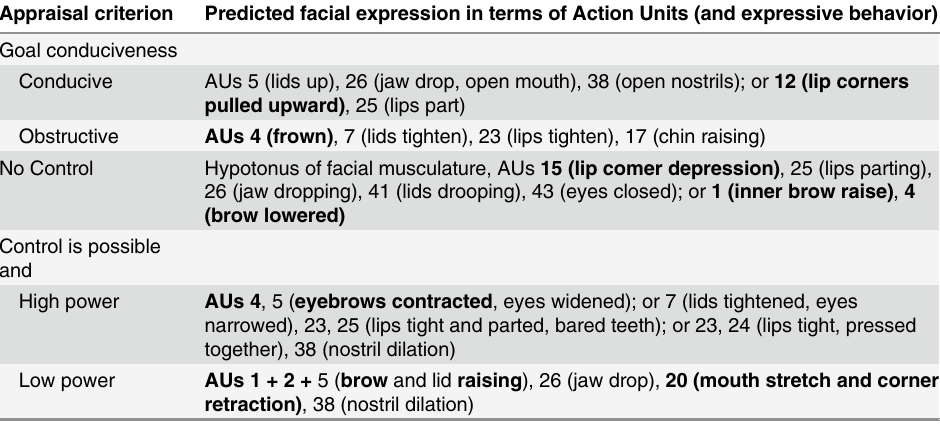
Table 1. Component Patterning Theory Predictions for Facial Action Units (AUs) Following Appraisal Outcomes. Appraisal criterion Predicted facial expression in terms of Action Units (and expressive behavior)